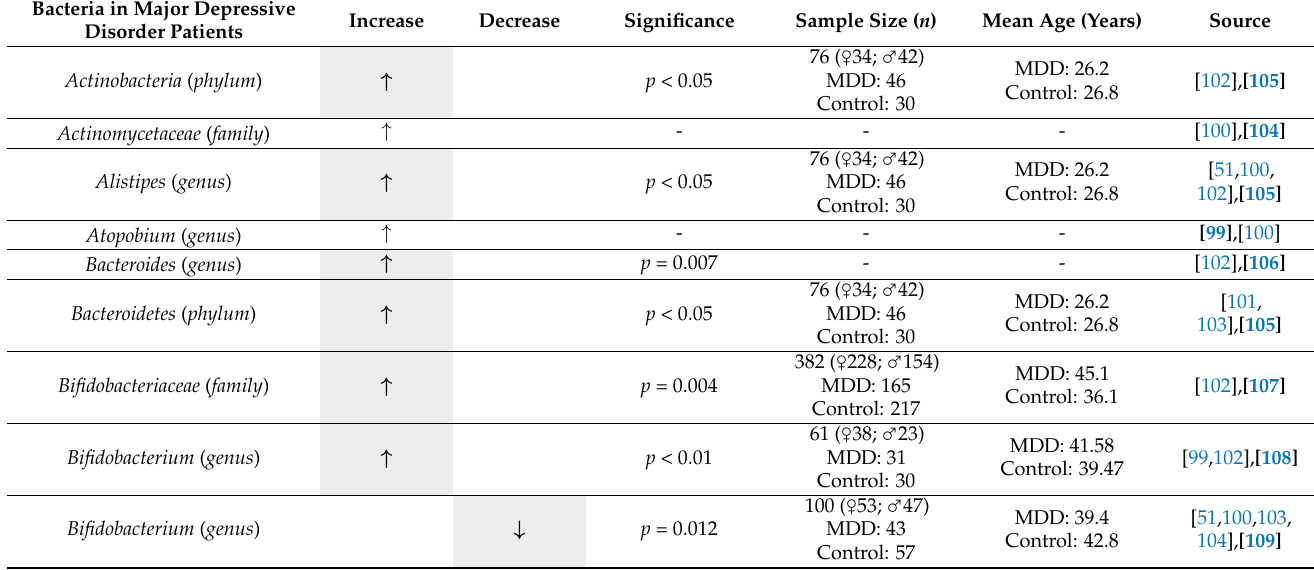
Table 7. Bacteria (with taxonomic level) were found in higher ( ↑ ) or lower ( ↓ ) abundance in patients suffering from major depressive disorder (MDD). Arrows of the significant results in at least one study are represented with a grey background ( p < 0.05 or LDA values > 2). “-” in the significance column indicate that no statements regarding the significance of the results were made in the corresponding studies. Empty cells mean that no significant differences could be identified. For the studies’ demographic characteristics, sample size and mean age were included. Sample size numbers are split into females and males for patients and healthy controls. The mean age is given for the patient group and the healthy control group, as a further breakdown for the gender groups was not consistently provided. The relevant source is shown in bold